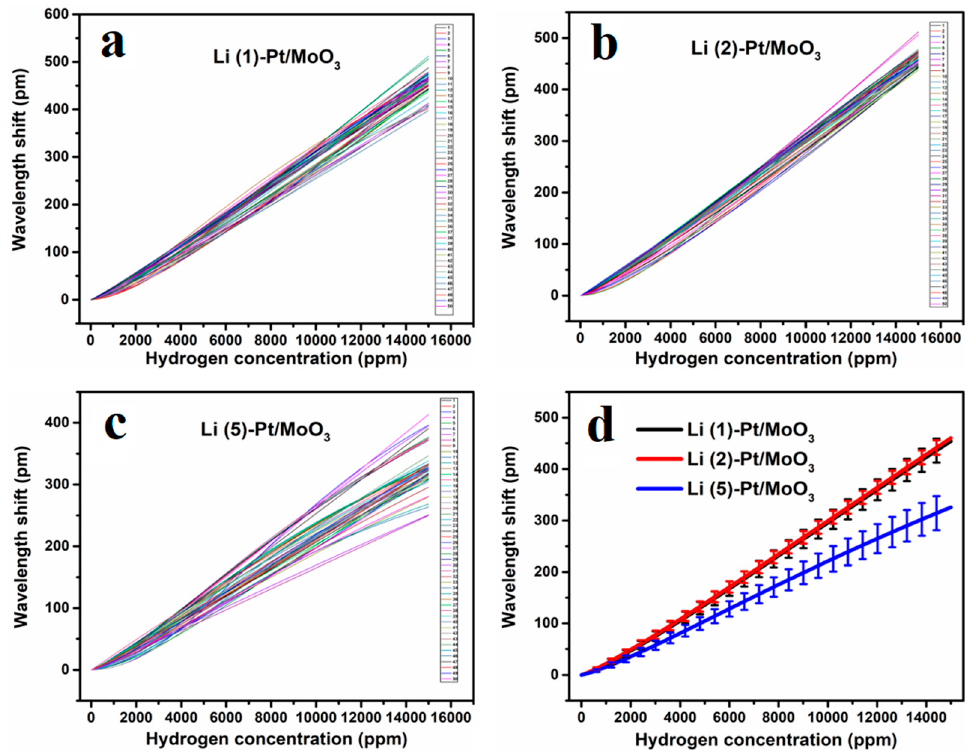
Figure 3. Repeatability of ( a ) Li(1)-Pt/MoO 3 , ( b ) Li(2)-Pt/MoO 3 , ( c ) Li(5)-Pt/MoO 3 and ( d ) error analyses of the three samples.